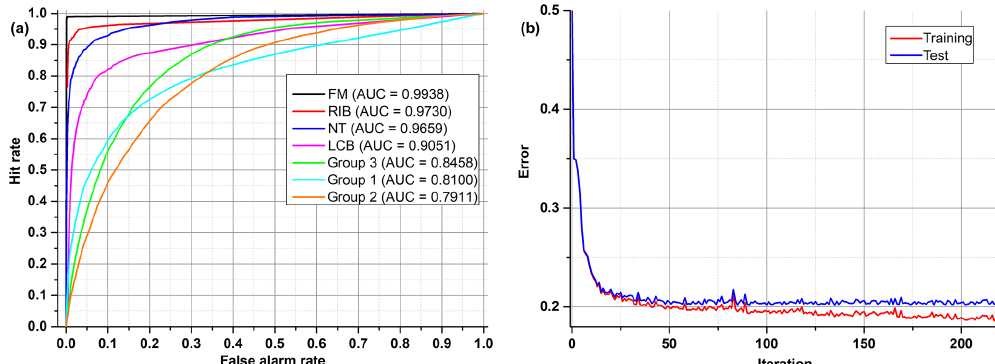
Figure 8. (a) ROC and (b) error progress of an ANN that classifies all samples.